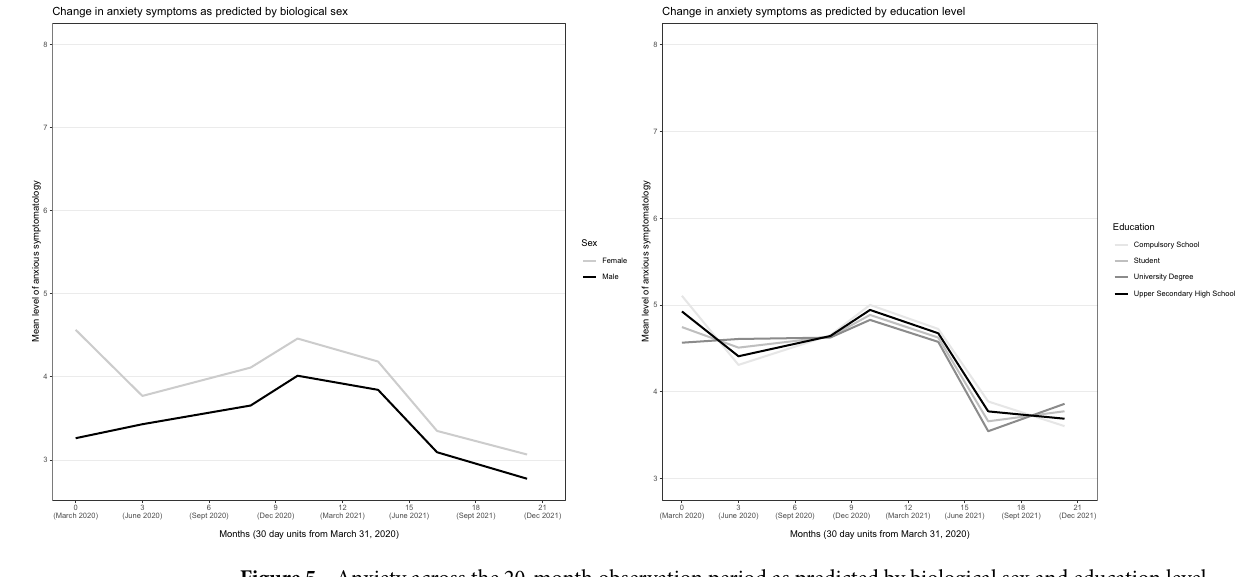
Figure 5. Anxiety across the 20-month observation period as predicted by biological sex and education level. Controlled for the influence of all other variables in the model.